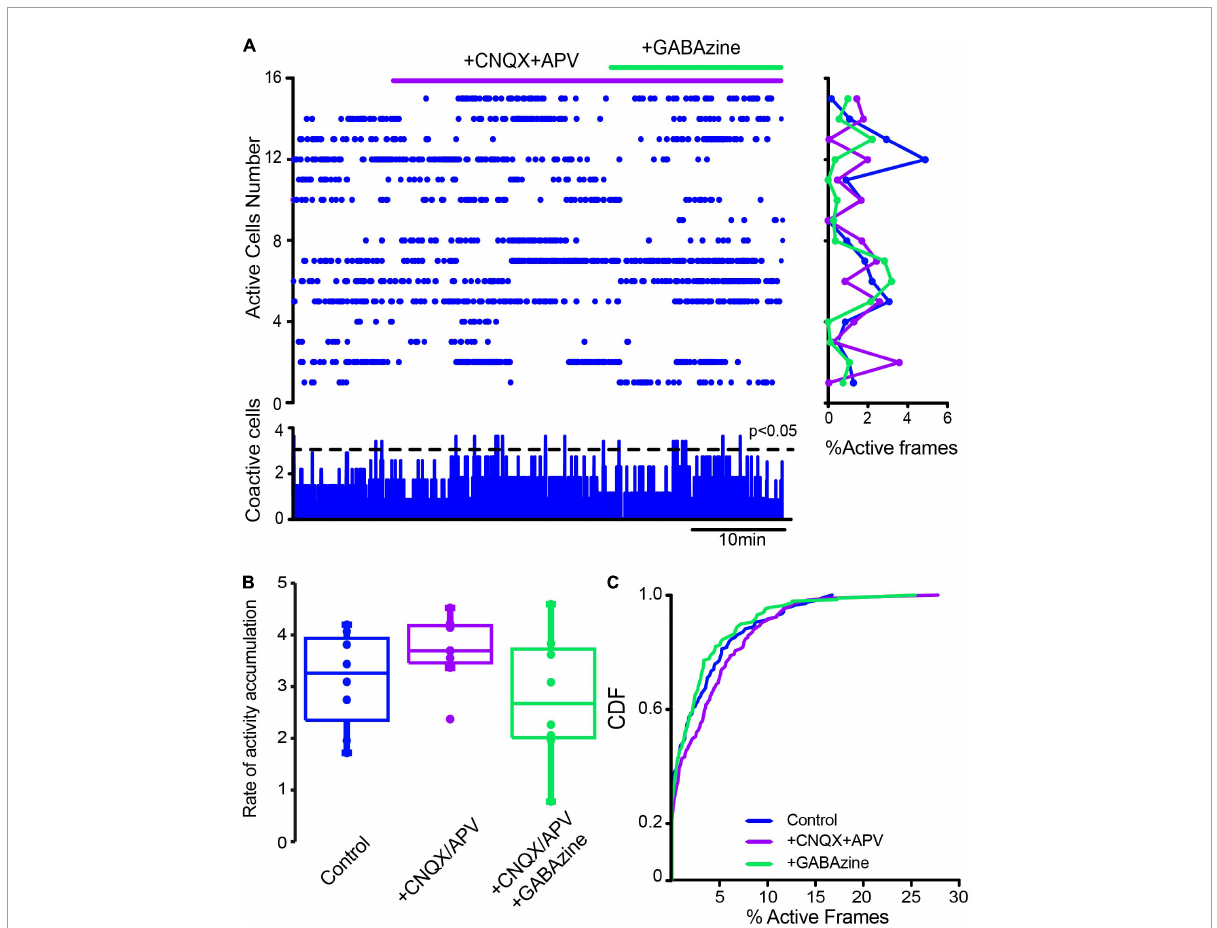
FIGURE7 Influence of glutamatergic inputs on cholinergic interneurons’ spontaneous activity in control conditions without stimulation. (A) The raster plot shows the spontaneous activity of CINs in control conditions and after applying 10 µ M CNQX and 50 µ M APV. Thereafter 10 µ M of GABAzine were administered. The histogram at the right shows activity per neuron (rows), histogram at the bottom shows activity per column (coactivity). (B) Box plots show samples of the rate of activity accumulation with non-significant changes (Wilcoxon’s T or Friedman tests). (C) Cumulative distribution functions (CDFs) of ChAT+ in control conditions and with the antagonists: CINs control vs. CINs + CNQX + APV: P = 0.087; + Gabazine: P = 0.24 (Kolmogorov-Smirnov test: n-CINS control = 116 cells, + CNQX + APV = 113; + Gabazine = 129 cells from n = 8 slices from 8 different